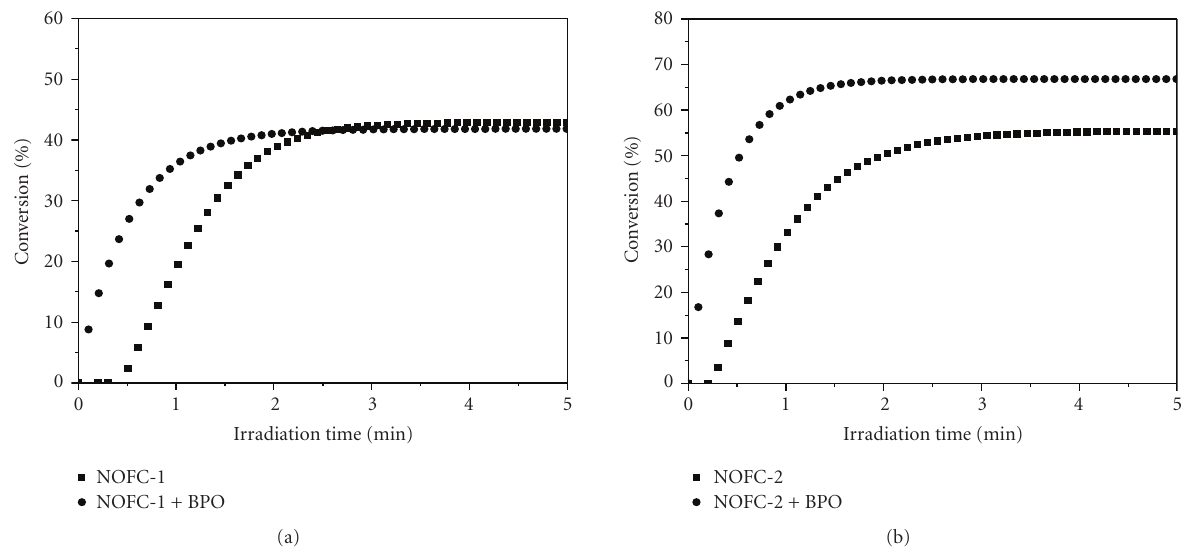
Figure 3: Conversion versus irradiation time plot of epoxy monomer ERL4221 initiated by 3.0 wt% photoinitiator with 3.0wt% BPO as photosensitizer (I = 80mW/cm 2 ).